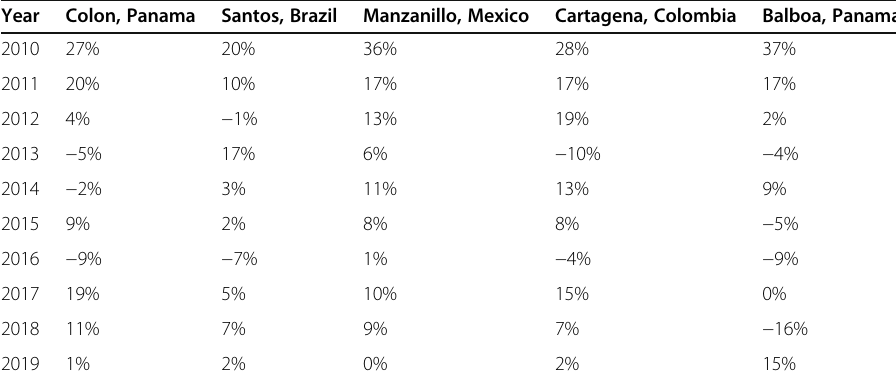
Table 2 Top 5 LAC ports percentage growth (%) in container throughput Year Colon, Panama Santos,